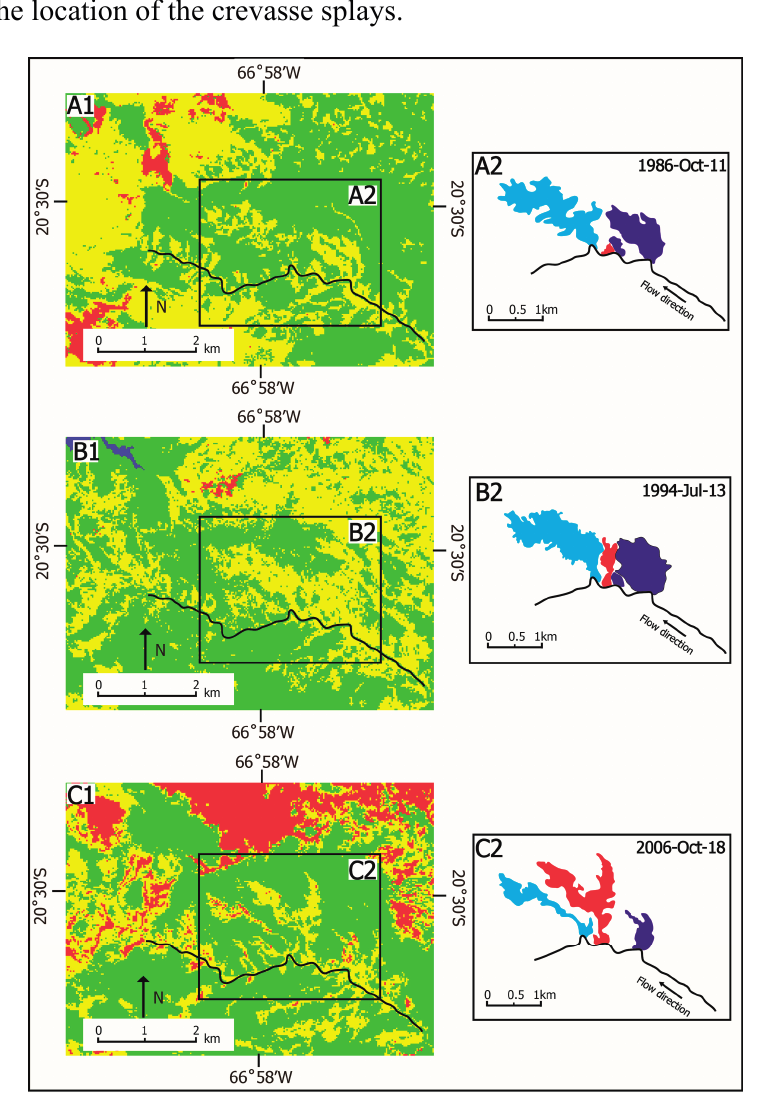
side are classification maps, where the yellow area represents the crevasse splay surface, the green area the floodplain, and red area the salty surface. Figures on the right-hand side are schematic diagrams of the development of the new crevasse splay in a time series. See Figure 1 for the location of the crevasse